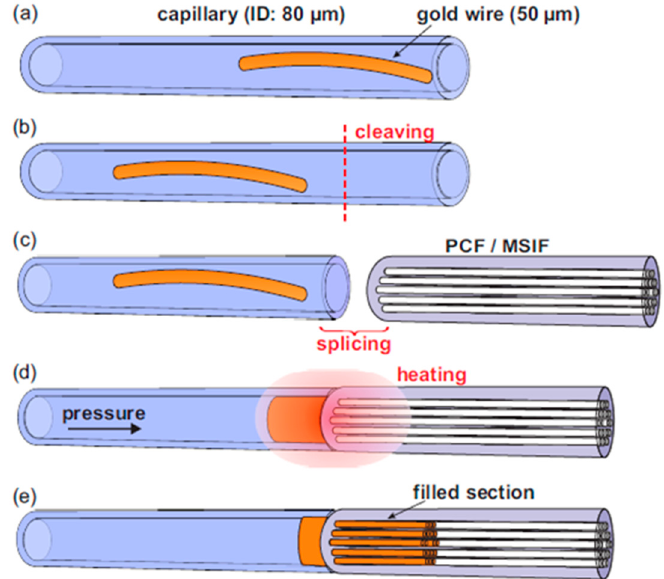
Figure 12. The schematic of the technique of pressure-assisted melt filling of the air channels of MOF samples. ( a ) The gold wire is inserted into the host capillary. ( b ) The fiber end face is cleaved. ( c ) The peace of the MOF sample is spliced to the host capillary. ( d ) The whole structure is placed into the furnace with the simultaneous connection of the host capillary to a pressure chamber. ( e ) The resulting structure of the hybrid optical fiber. Adapted with permission from [79]. © The Optical Society.